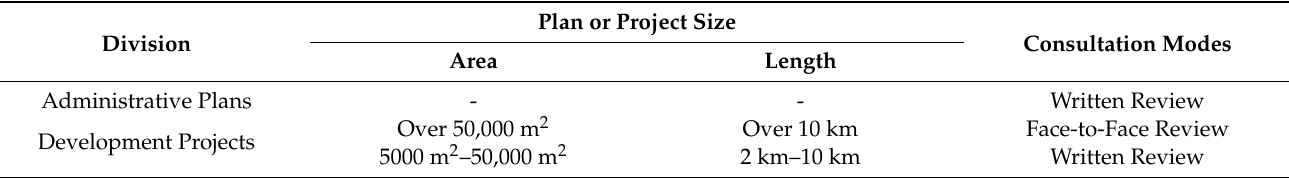
Table 4. Method of consultation by subject and